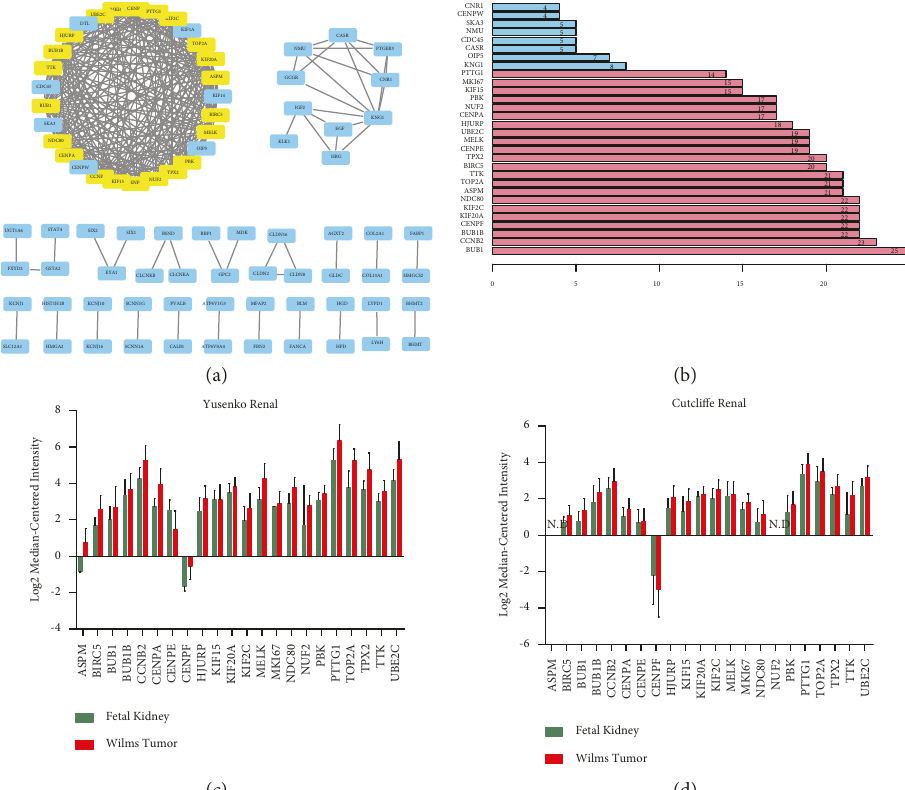
Figure 4: Identification and expression validation of hub genes. (a) The PPI network of WT-specific mRNAs shown by Cytoscape. (b) The degree distribution of the PPI network of the top 30 WT-specific mRNAs. (c) Expression validation of the hub genes performed with the Yusenko renal dataset. Mean SEM. (d) Expression validation of the hub genes performed with the Cutcliffe renal dataset. Mean ±